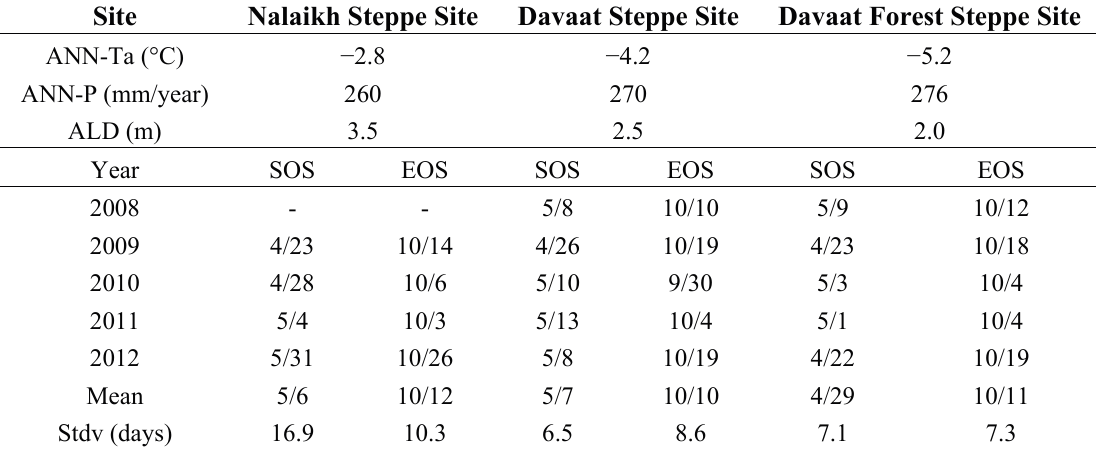
Table 2. Climate, active layer depth (ALD) over permafrost, and phenological dates at three experiment sites. ANN-Ta is the annual mean air temperature, ANN-P is the annual total precipitation, and Stdv is the standard